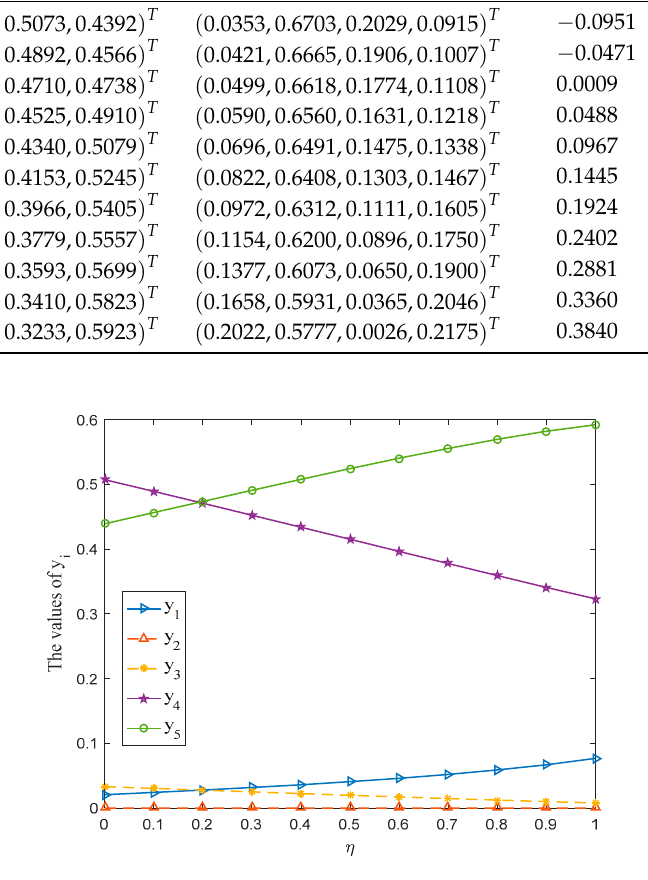
Figure 7. Gain-floor U ∗ and loss-ceiling V ∗ with parameter η varying from 0 to 1.